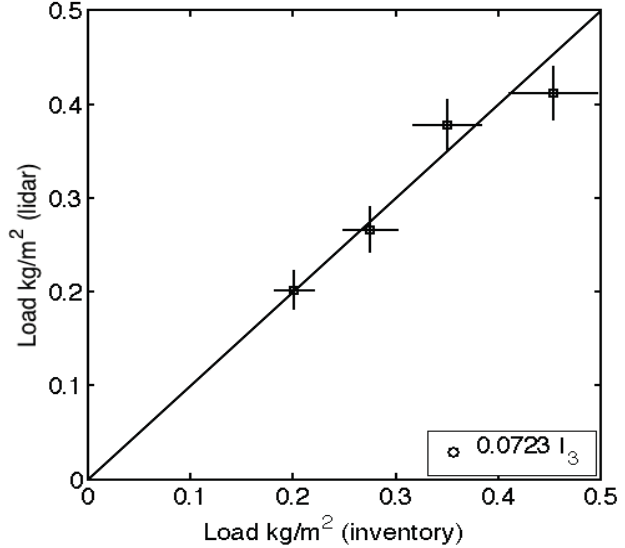
Figure 10. TLS-based (using I 3 ) against inventory-based leaf loads above 4 m. The horizontal and vertical bars represent the confidence interval at 95% for both inventory and TLS